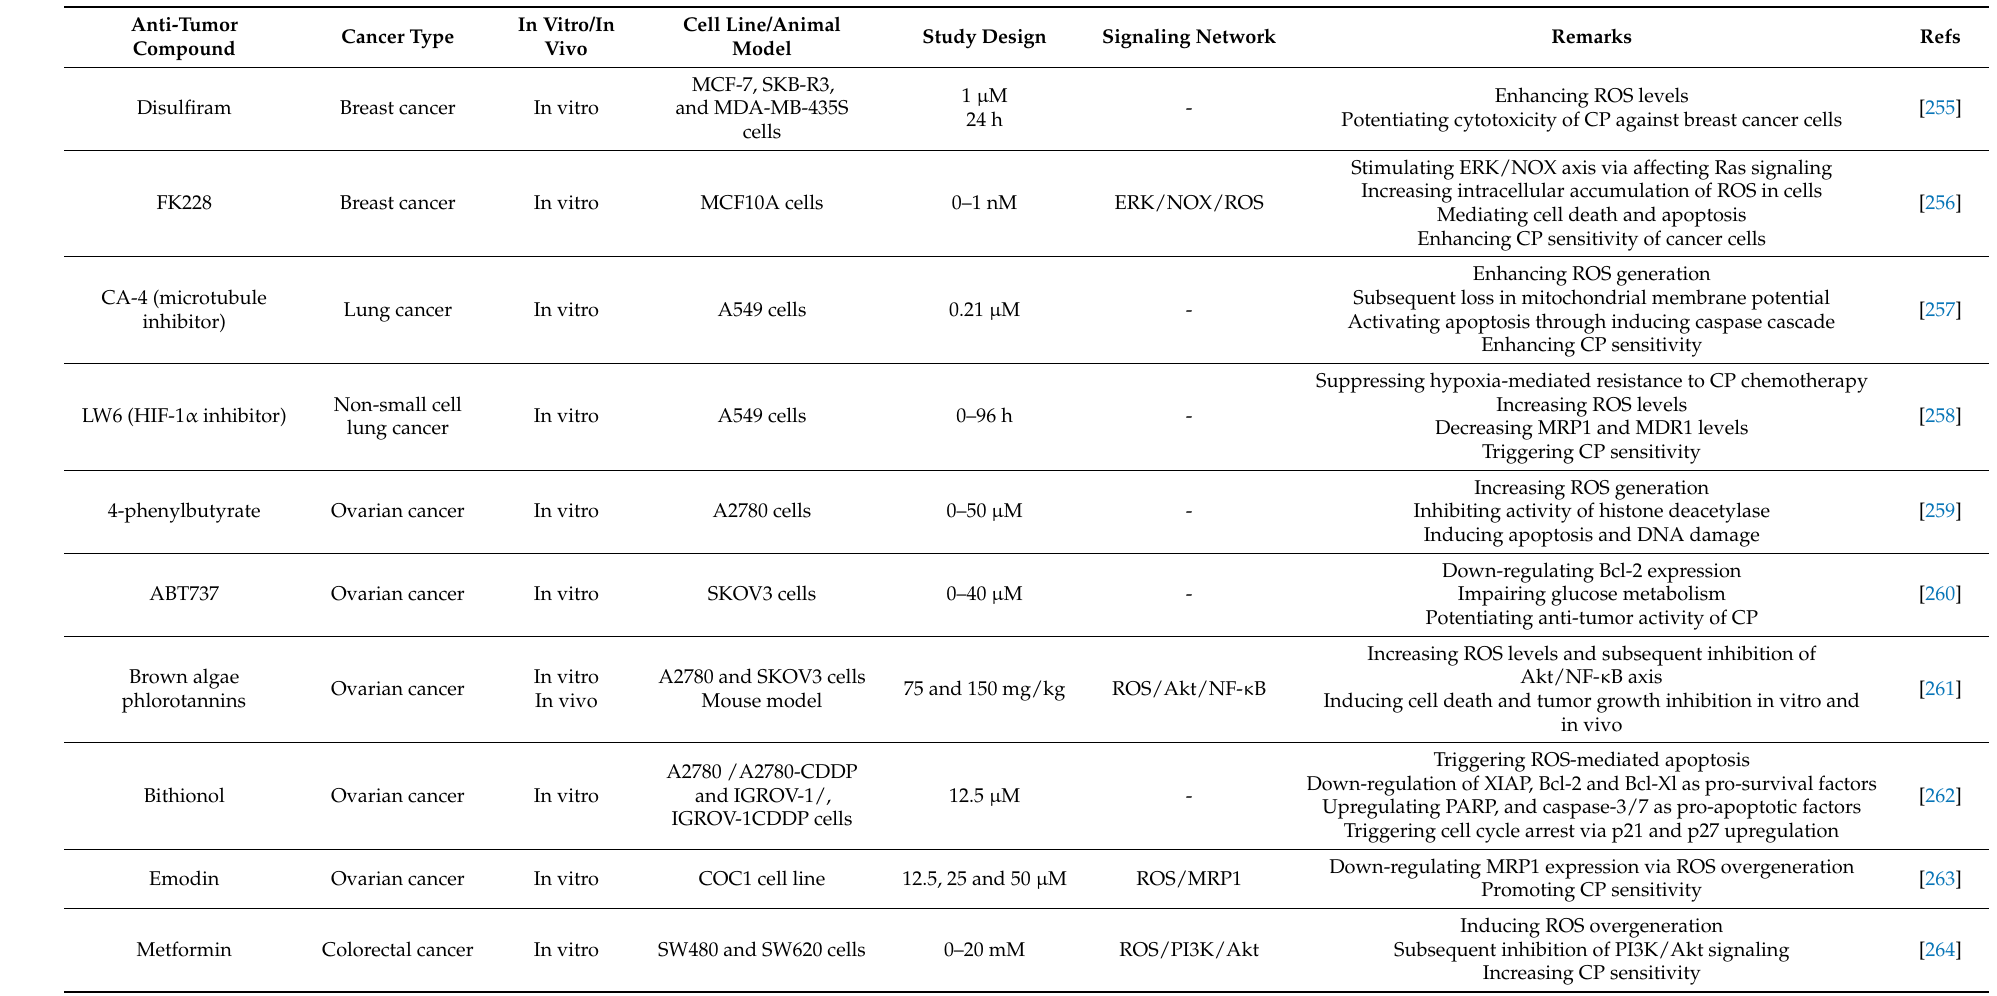
Table 3. Anti-tumor compounds applied in regulating ROS levels and enhancing CP